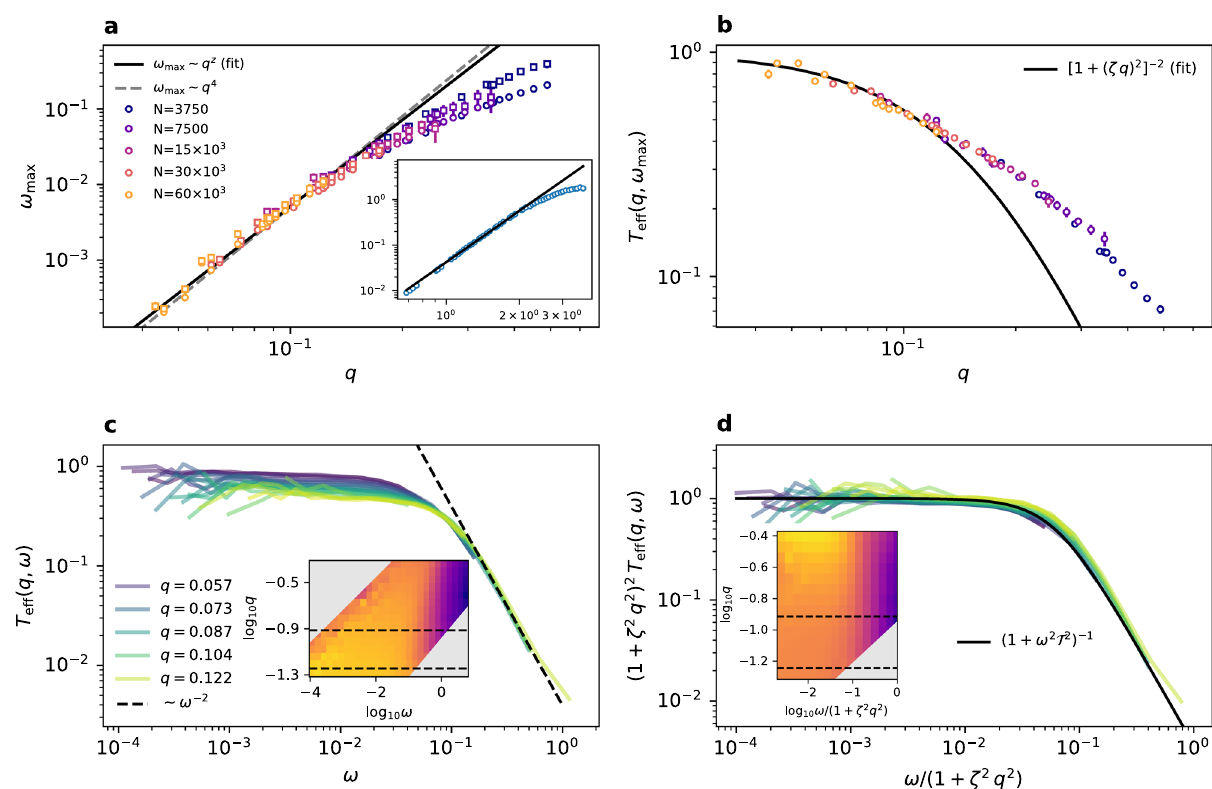
Fig. 3 Relaxation frequency and effective temperature of the critical active system. a Peak frequency ω max of the correlator (circles) and of the response (squares) as a function of q . Error-bars represent the fi t error on the peak position. Different colors indicate different systems sizes (see legend). The straight full line is a power-law fi t of the low- q correlator peak-frequencies (i.e. the yellow points for which N = 60 × 10 3 ), yielding a critical exponent z very close to the Ising one ( z = 3.75), which is lower than the mean- fi eld value (the best fi t with z = 4 is indicated by the dashed line). The inset (same axes as the main panel) shows the peak frequency for the equilibrium triangular lattice gas. Deviations from the scaling ω max (cid:4) q 4 are also found at high q -values. b Effective temperature evaluated at the correlator peak-frequency T eff ð q ; ω Þ max as a function of q (different colors indicate different system sizes with the same as in a . Error-bars represent the linear propagation of the error on the peak amplitude. The black curve is a fi t of the low- q data by means of the expression found in the one-loop colored-noise-driven fi eld theory (Eq. (11)). c Frequency resolved effective temperature T eff ( q , ω ) in the low- q regime (colored curves), different colors indicate different q -values (see legend). The dashed line represents the power-law ω − 2 predicted by the theory for asymptotic behavior of T eff . The inset shows ln ½ T eff ð q ; ω Þ(cid:5) as color map (value increasing from blue to orange) at all q and ω -s. The gray area represents the highest and lowest ω measured at each q determined by the simulation duration and sampling frequency. The dashed black lines indicate the of low q -values range selected for the main panel. d Data in c are scaled according to the theory. Collapsed data are well fi tted by the Lorentzian predicted by the theory (full line). The inset is the same of the inset of c but for the scaled effective temperature appearing in the main